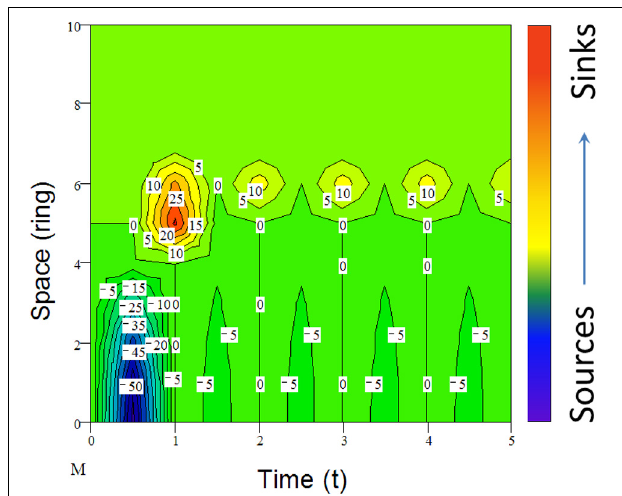
FIGURE 6 | An example of simulated population dynamics across space from center (bottom) to margin (top patches) and time (reproductive seasons). For active migrants (mostly animals), long-distance dispersal (e.g., leptokurtic) could lead to the establishment of “pocket” populations (top) with long-persisting certain genotypes (Ibrahim et al., 1996). Positive numbers indicate the immigrants from the “source” or center and negative numbers (density) are the emigrants to the “sinks” or margin, following the active migration function ( M ) from j th to i th ring ( i th ring is located outside of the present range in Figure 2 ; for details, see Guo et al.,